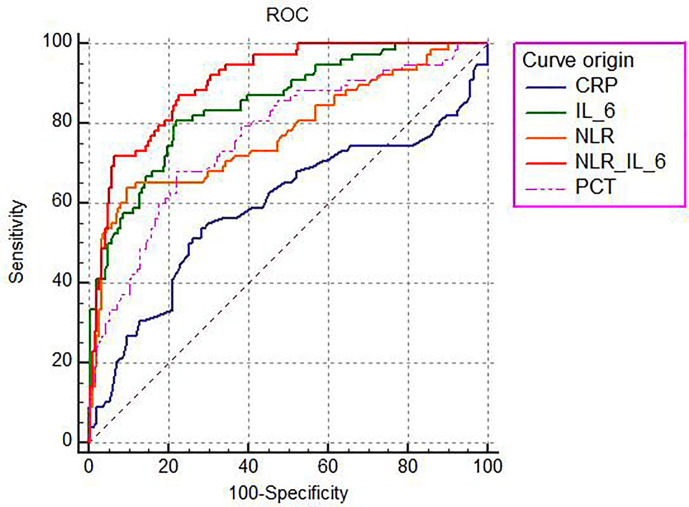
The ROC analysis of the studied biomarkers for predicting the development of 28-day mortality in sepsis.